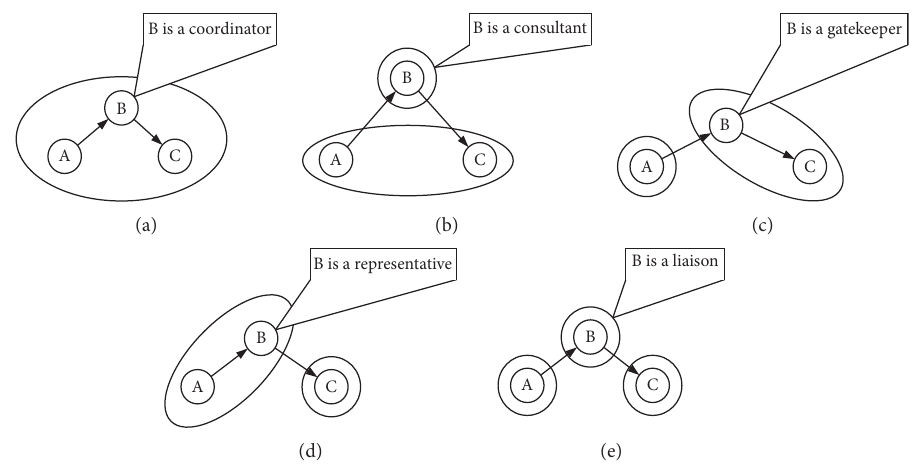
Figure 2: Descriptions of five kinds of brokerage